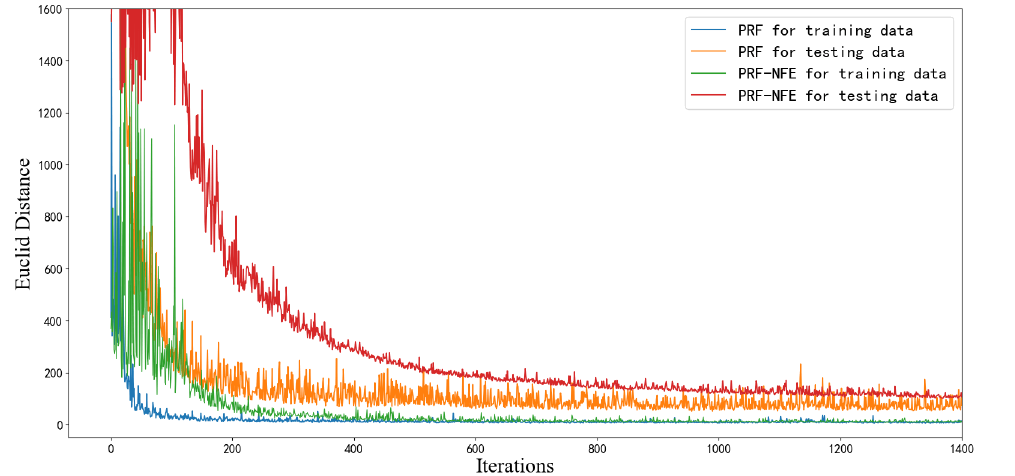
Figure 9. The convergence curves of PRF and